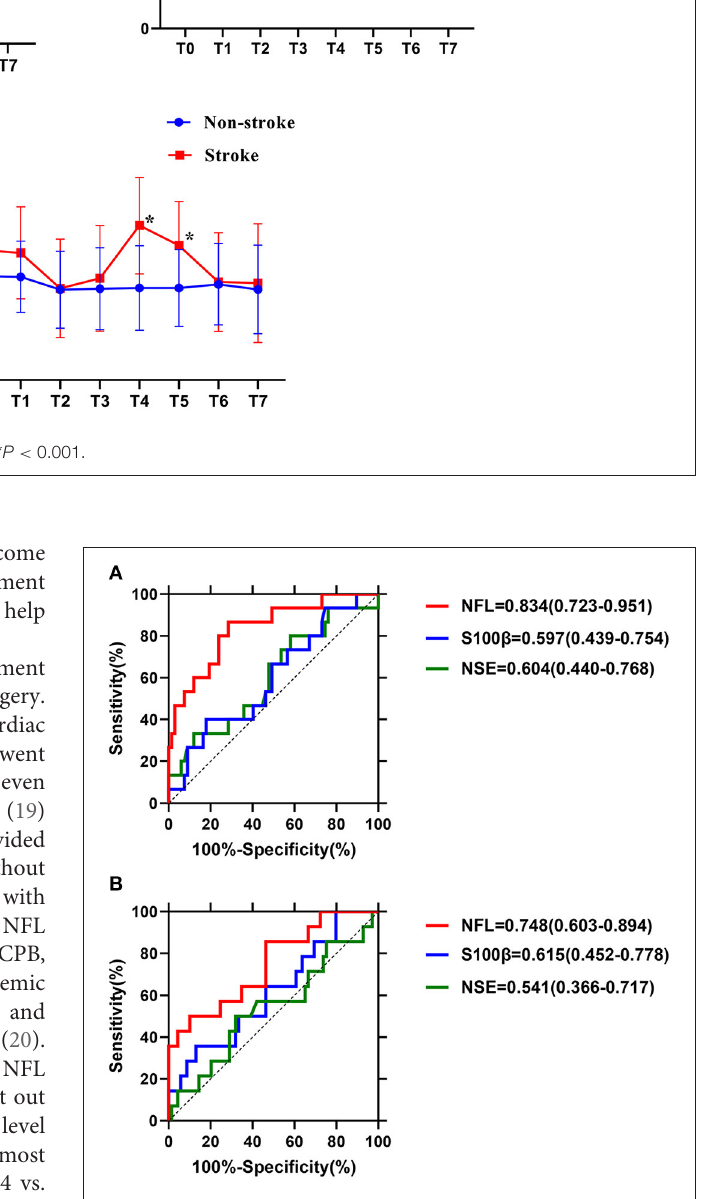
of professional boxers (21). Interestingly, although there was no statistical difference, patients in the stroke group had a higher baseline value (T0) than those in the non-stroke